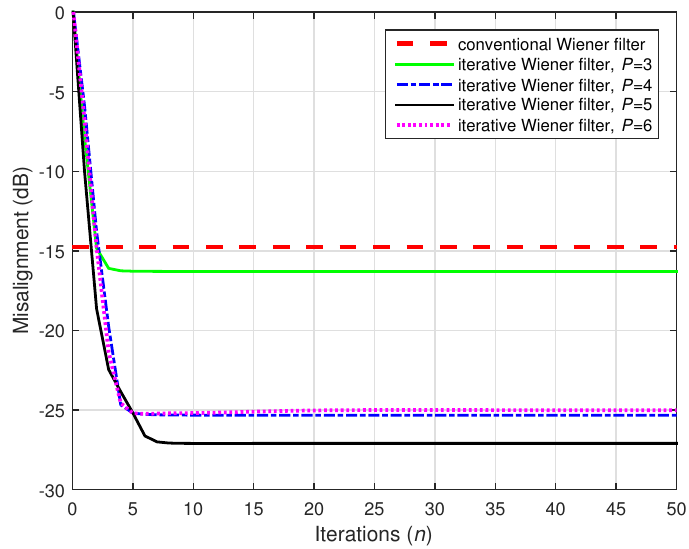
Figure 9. Performances of the conventional and iterative Wiener filters, using N = 2500. The input signals were independent AR(1) processes, M = 4, L = 500, and SNR = 30